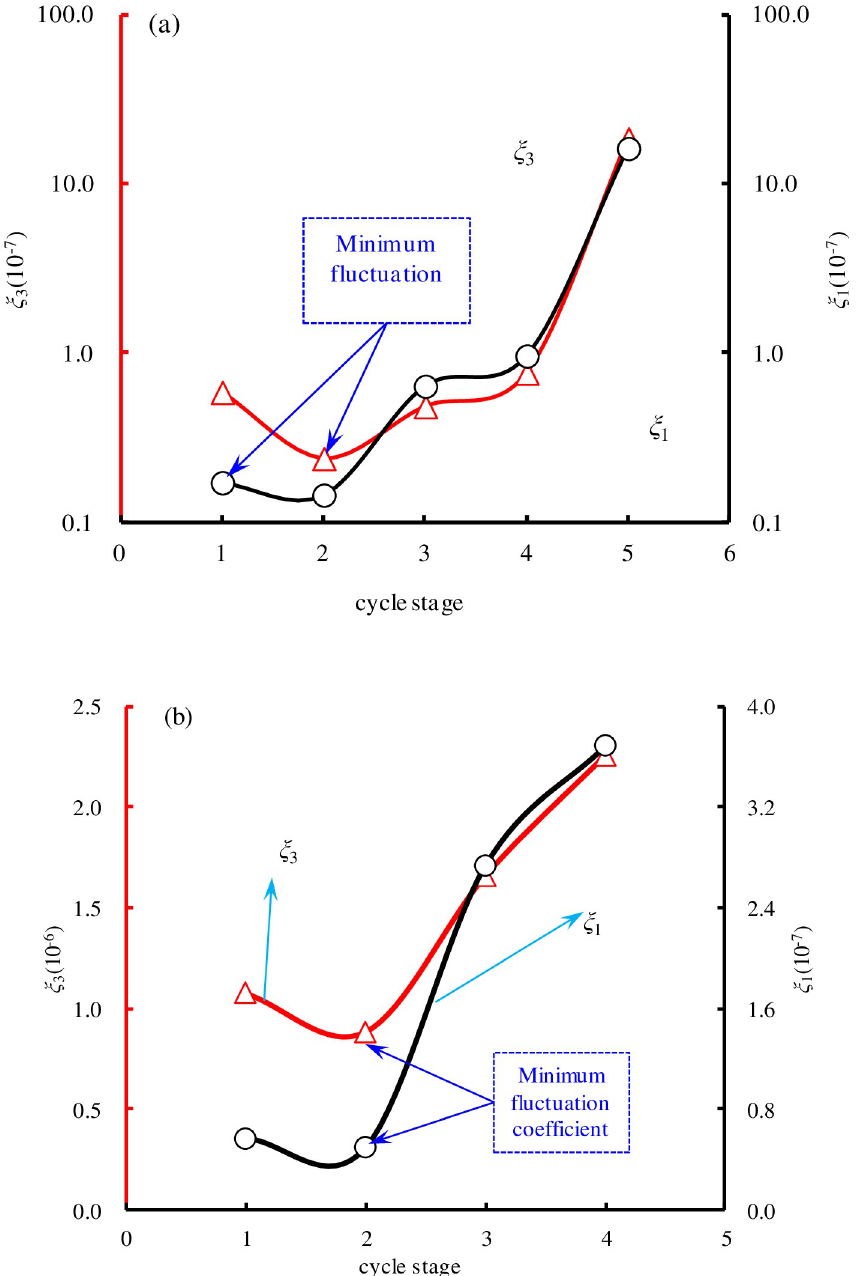
Fig 11. Fluctuation coefficient curve of relative residual strain: (a) SS-1; (b) SS-2. gradually compacted, and the rock mass tends to be elastic. Thus, the fluctuation of Δ ε decreased in second cycle stage, and the variance of Δ ε tinued to increase, new pores and fissures gradually expanded, and local failures resulted in unstable deformations. The fluctuation of Δ ε rock mass became increasingly unstable. This show that the deformation has great fluctuations when the rock mass tends to instability. The characteristics of Δ ε whether rock mass failure will occur during cyclic loading.